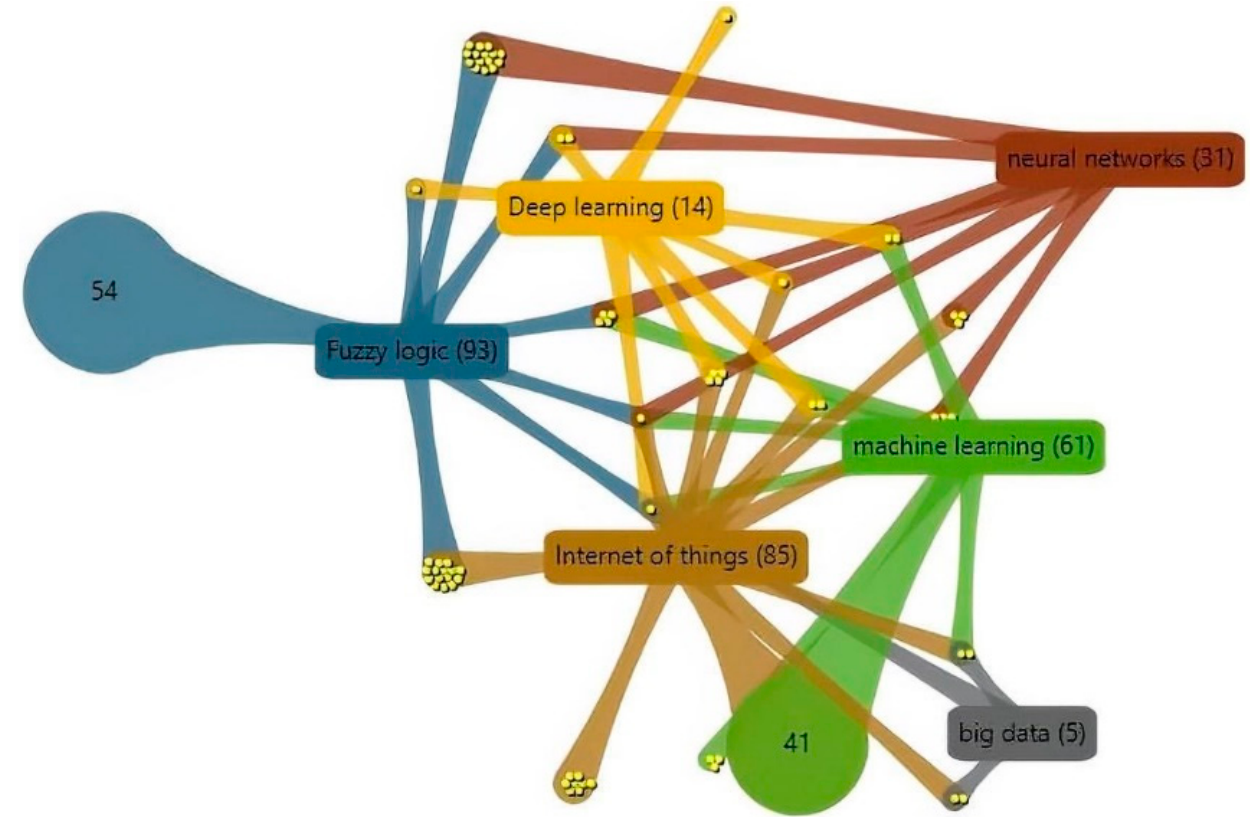
Figure 5. A nodal relationship diagram of the correlations among technologies. Obtained using VantagePoint.